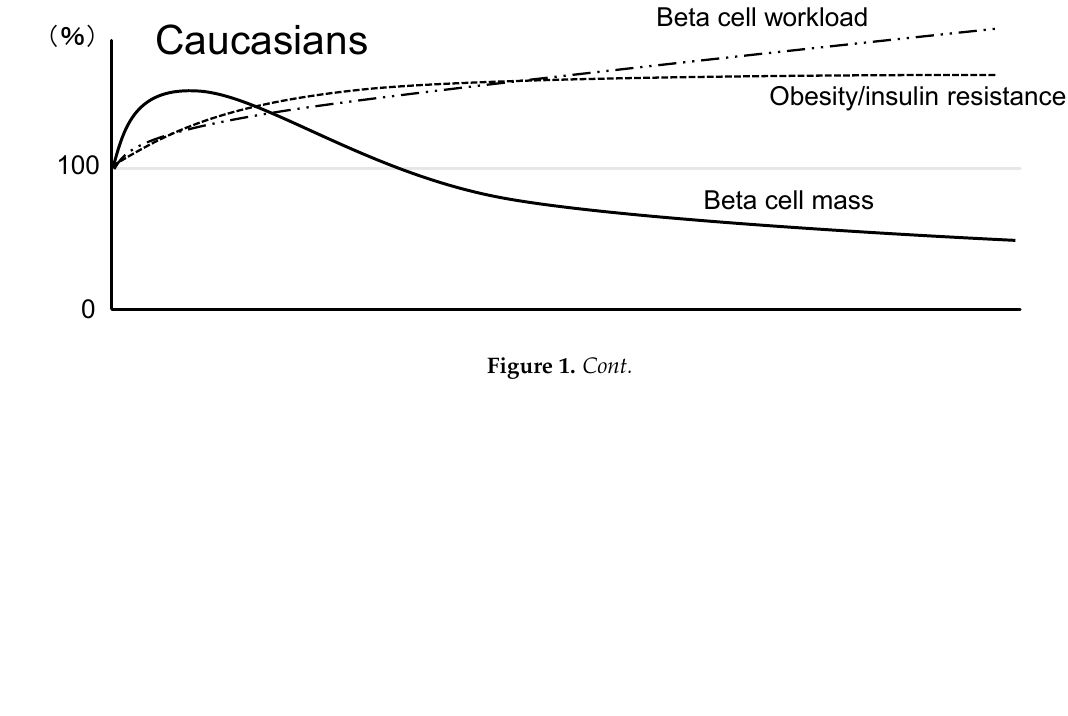
T2DMNGT PreDM Figure 1. Hypothetical schema of different changes in beta cell mass in relation to obesity/insulin resistance and beta cell workload during the development of glucose intolerance in Caucasians and Asians (Japanese). NGT: normal glucose tolerance; PreDM: prediabetes; T2DM: type 2 diabetes. Beta cell mass increases to adapt to the increased demand in obese nondiabetic individuals in the Caucasian population, while beta cell mass expansion in the face of insulin resistance is extremely limited in Asians. Despite less obesity/insulin resistance, the limited increase in beta cell mass in Asians results in a similar increase in beta cell workload to that in Caucasians. Excess beta cell workload may eventually cause loss of beta cell mass. Once beta cell mass is reduced, beta cell workload will further increase, resulting in a vicious cycle. With progression to prediabetes and overt diabetes, progressive decline of beta cell mass underlies the disease. 4. Treatment Strategy for T2DM in Asian Population The current perspective suggests that beta cell failure and a deficit of functional beta cell mass occur far before the onset of T2DM and possibly even before the onset of IGT [6]. This point emphasizes that it is important to preserve or recover functional beta cell mass as a management and treatment strategy for T2DM [38]. Several clinical trials have shown that lifestyle modification and insulin sensitizers that decrease beta cell workload [39,40], but not insulin secretagogues [41], are effective at preventing the development of T2DM. In the Asian population, reducing beta cell workload seems to be the most effective treatment strategy for T2DM. A proposed concept of a treatment strategy for T2DM in Asians in relation to functional beta cell mass is shown in Figure 2. Lifestyle modification such as nutritional therapy, exercise, and weight loss remains the essential factor of treatment of T2DM at any stage of the disease including IGT. Since metformin is effective not only in obese patients but also in lean patients with T2DM [42], and reduces insulin demand by lowering hepatic glucose production, starting therapy by metformin in addition to lifestyle modification should be considered as early a stage of diabetes as possible in patients without contraindication. The use of incretin therapy, which enhances physiological insulin secretion without serious adverse effects, is now widely used for treatment of T2DM. Incretin treatment has been shown to increase beta cell mass in rodents; however, this effect has not been confirmed in humans [43]. On the other hand, insulin secretagogues such as sulphonylureas may be used at only a minimal dose rather to enhance incretin action. Since it has